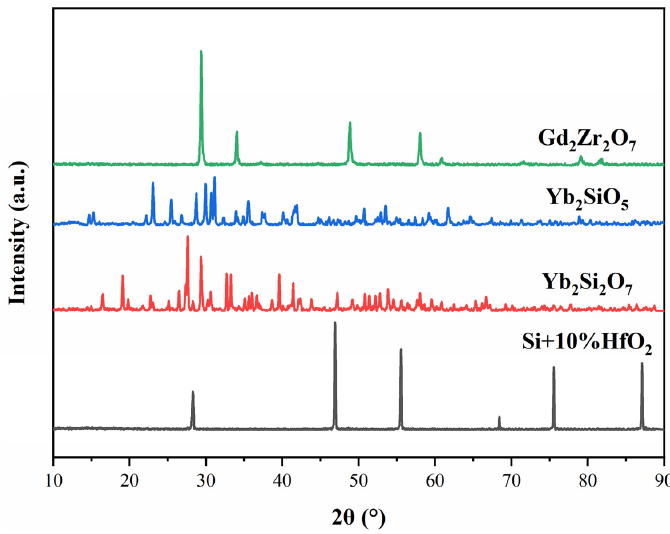
Figure 3. XRD patterns of each coating in T/EBCs coating.